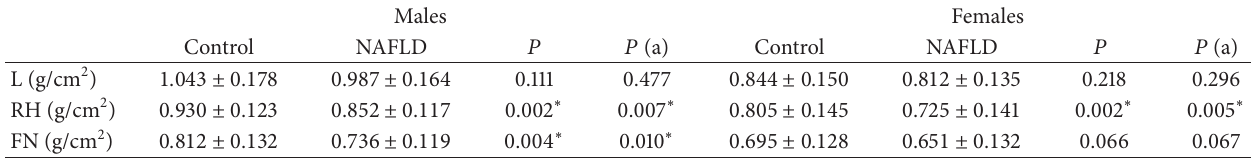
Table 2: BMD in control group and NAFLD